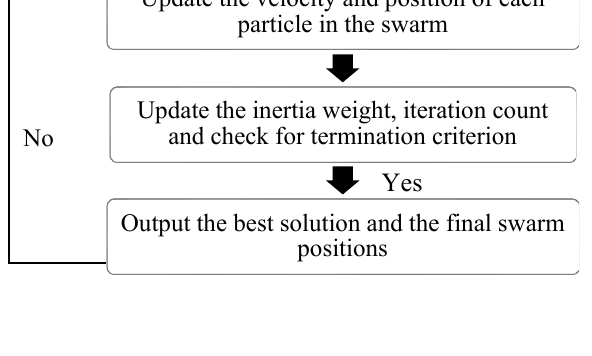
Figure 7. Flowchart of PSO